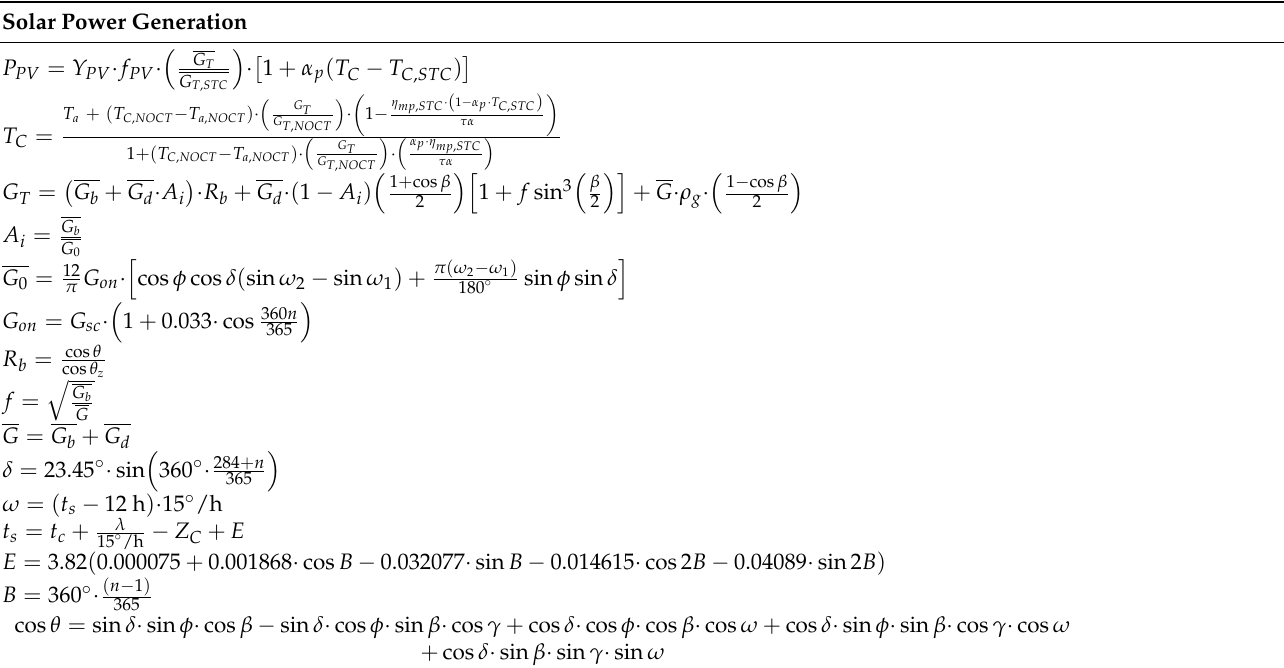
Table 1. Detailed calculation steps of solar power and heat generation